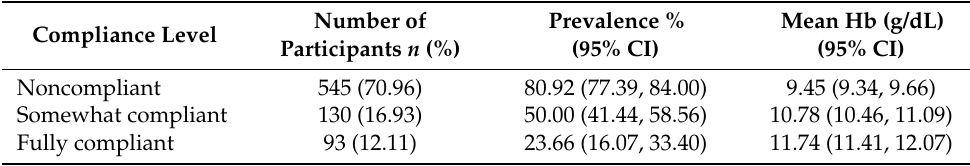
Table 5. Prevalence of anemia and mean Hb levels in sensitivity